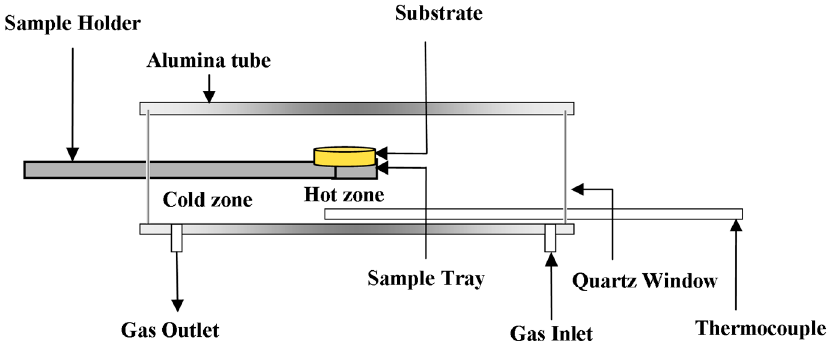
Figure 1. A schematic representation of the experimental arrangement.